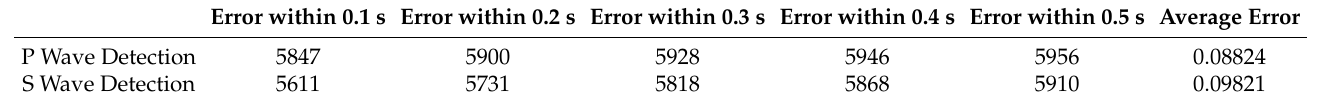
Table 3. The different testing set error